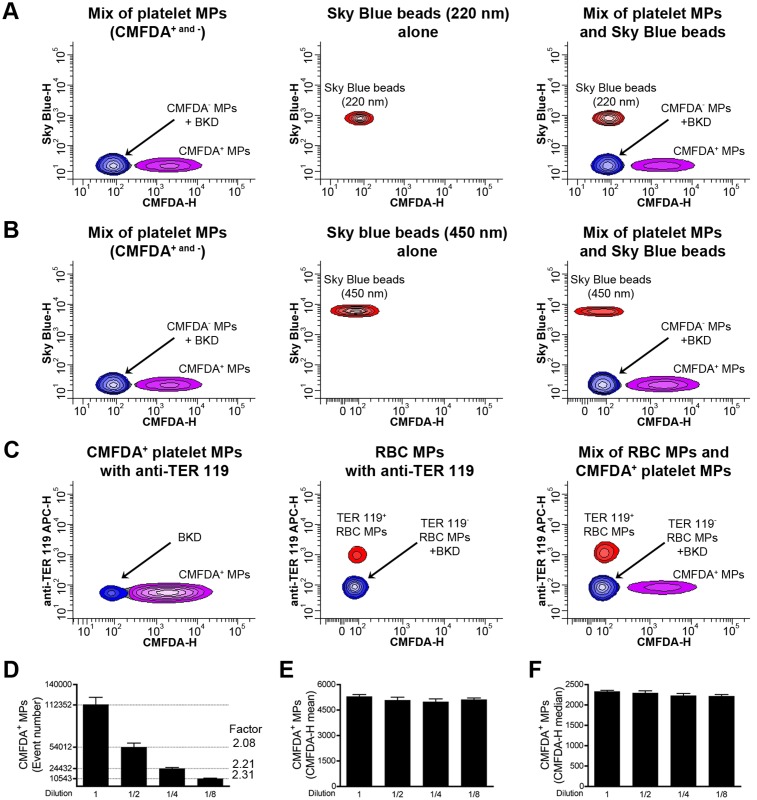
Study of swarm detection in high sensitivity flow cytometry.(A) A mixture of CMFDA- and CMFDA+ platelet MPs (CMFDA- and +) and sky blue beads (220 nm in diameter) were analyzed alone (left and middle panel respectively) or mixed (right panel) and their detection resolved on the basis of fluorescence. (B) CMFDA- and + platelet MPs and sky blue beads (450 nm in diameter) were analyzed alone (left and middle panel respectively) or mixed (right panel) prior to detection on the basis of fluorescence. (C) CMFDA+ platelet MPs and RBC MPs labeled with antibodies directed against TER 119 are analyzed alone (left and middle panel respectively) or mixed (right panel). (D, E, F) CMFDA+ platelet MPs were diluted serially thrice (2-fold dilution) and analyzed by high sensitivity flow cytometry to determine their concentration (D), the CMFDA-height (H) mean of fluorescence (E) and the CMFDA-H median of fluorescence (F) are presented. Data are mean ± SEM of 5 independent experiments. BKD = Background noise.